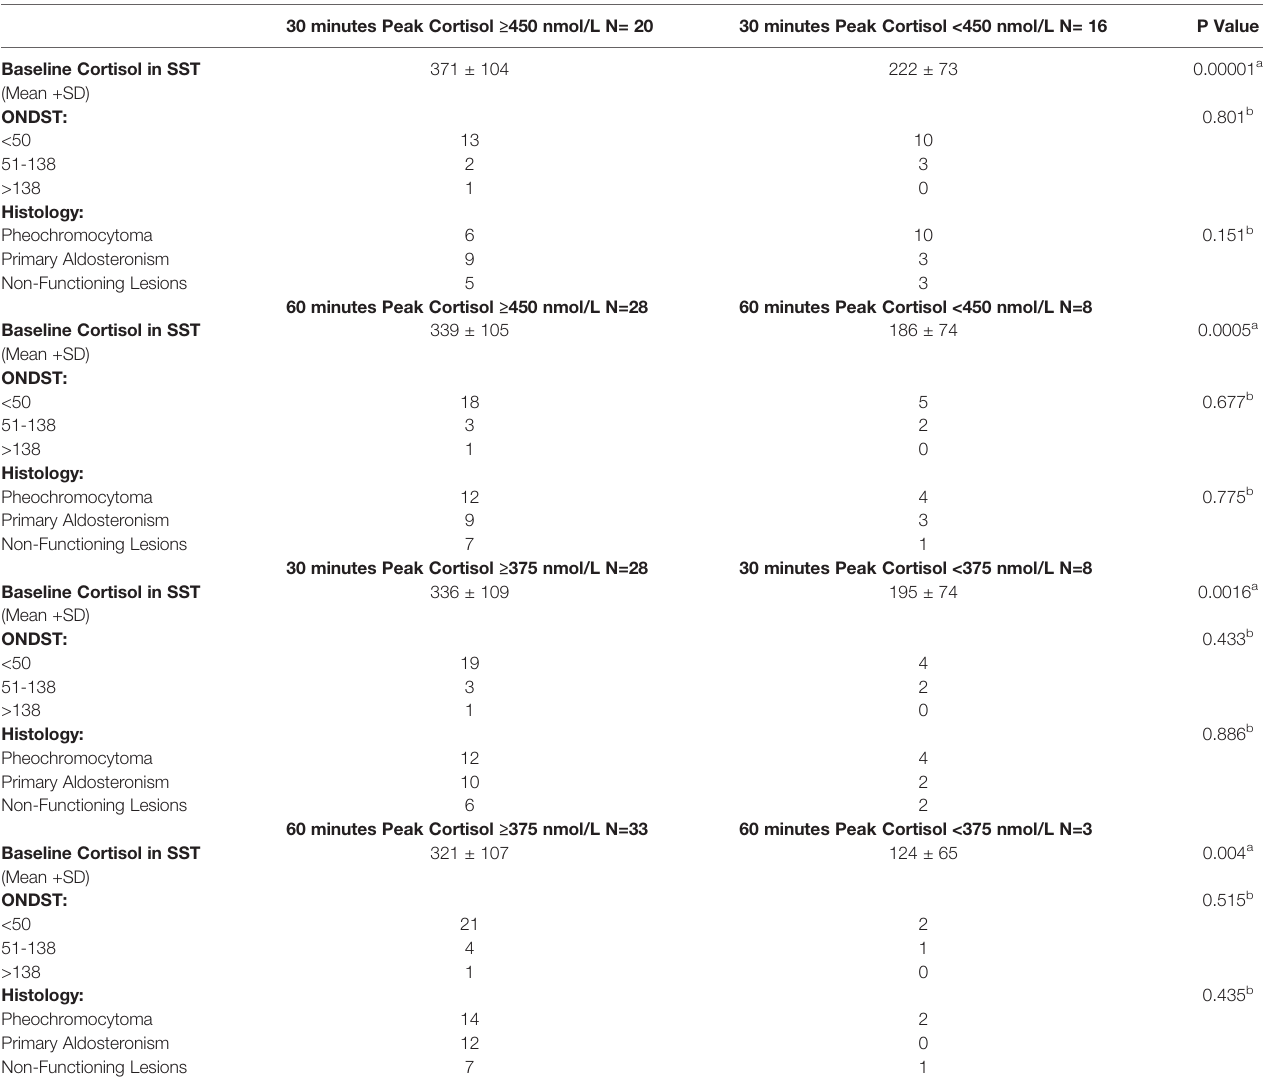
TABLE 2 | Distribution of ONDST, baseline cortisol and histology based on different peak of cortisol